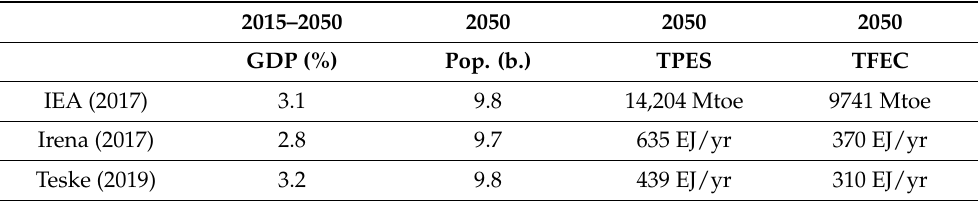
Table 2. Main scenario